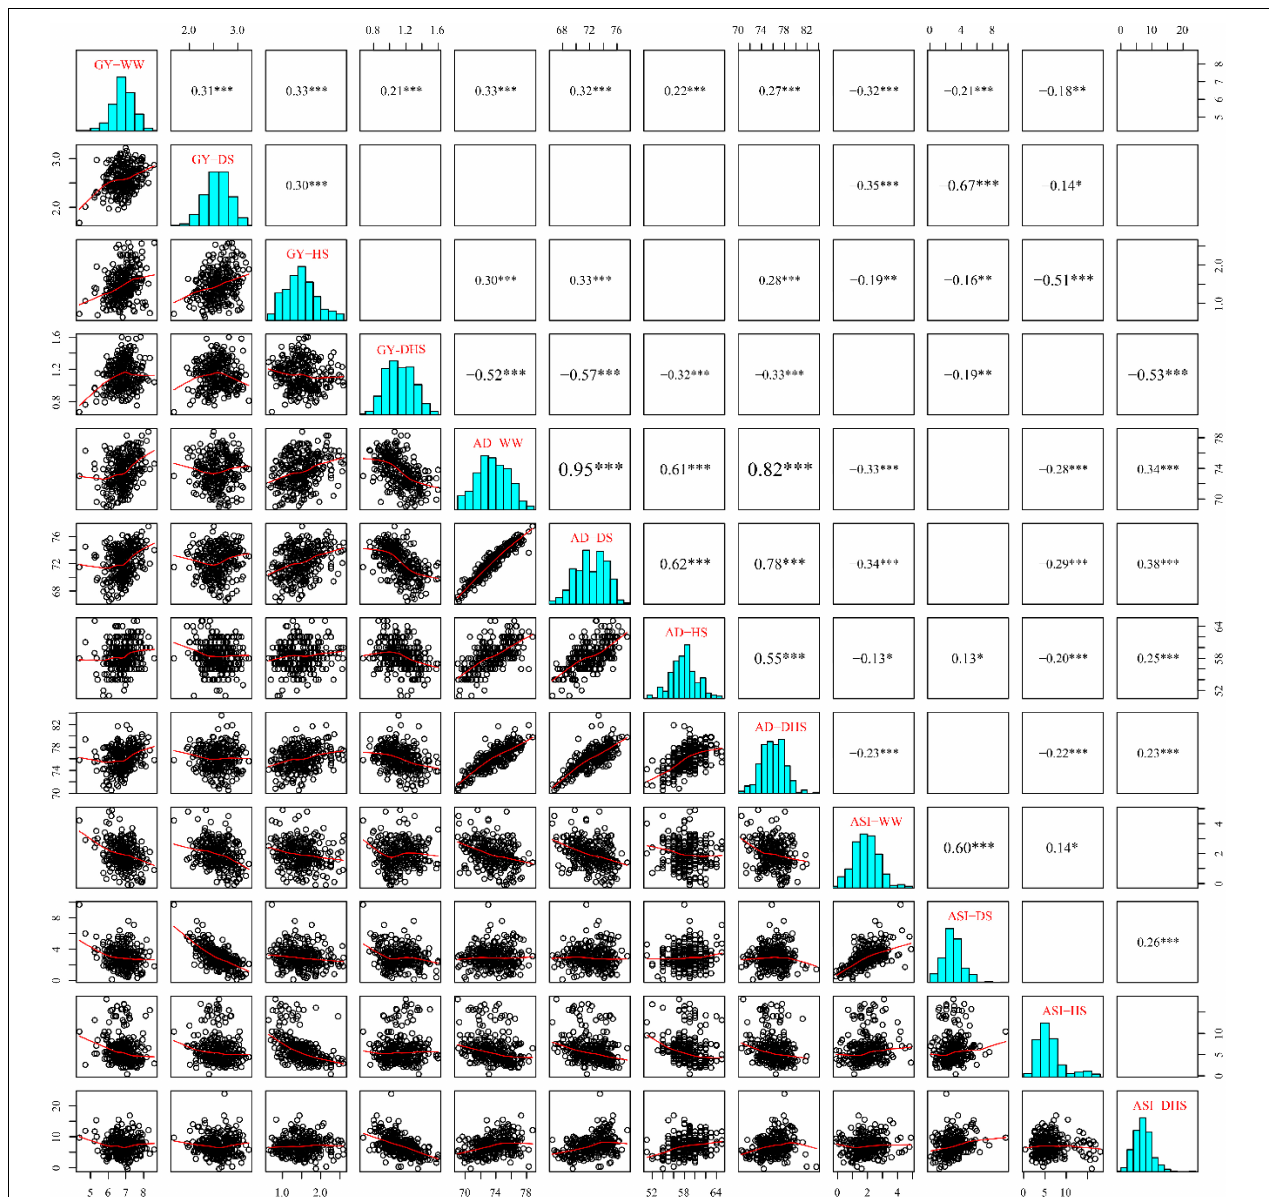
FIGURE 2 | The pairwise correlations among the 12 trait-environment combinations based on the BLUP values. The traits of GY, AD and ASI are abbreviated from grain yield, anthesis date and anthesis–silking interval, respectively. The environments of WW, DS, HS, and DHS are abbreviated from well-watered, drought stress, heat stress and combined drought and heat stress management conditions. The numbers with one or more star(s) represents the Pearson correlation coefficients at different significances ( ∗ : 0.05; ∗∗ : 0.01; ∗∗∗ : 0.001) and the word size of them indicate the correlation level. The blank boxes indicate that there was no significant correlation for the corresponding